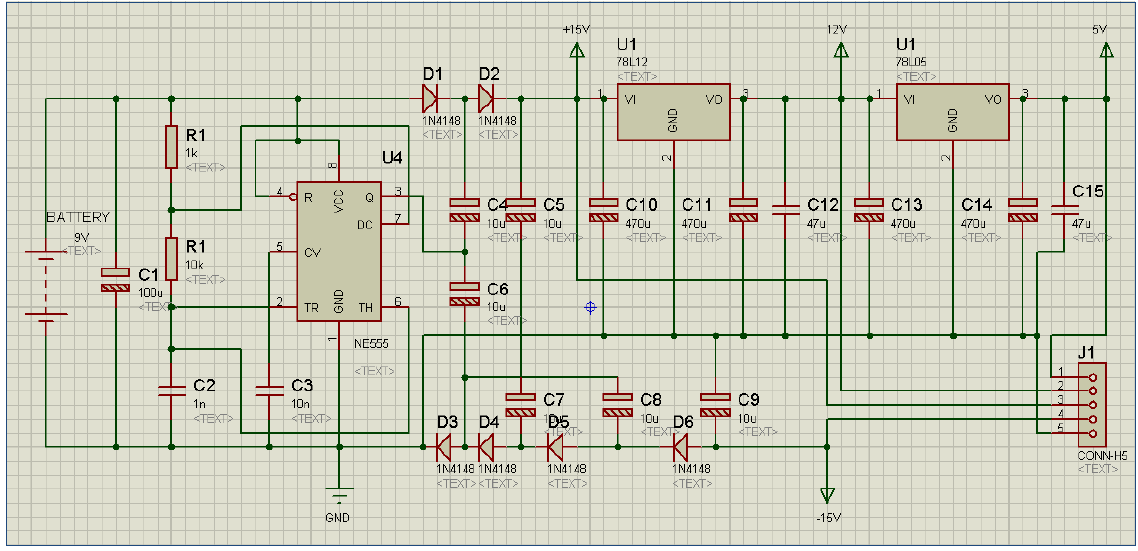
Figure 10. Power supply for our data